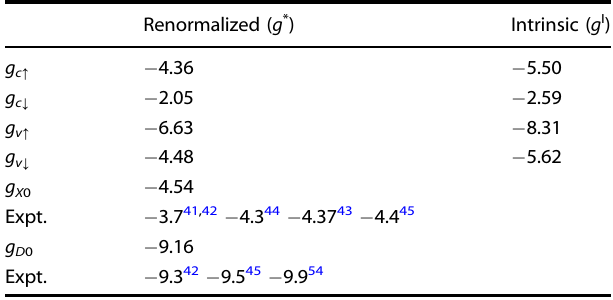
Table 1. GW single band and exciton g-factors of undoped ML WSe 2 at the K valley. Renormalized ( g * )